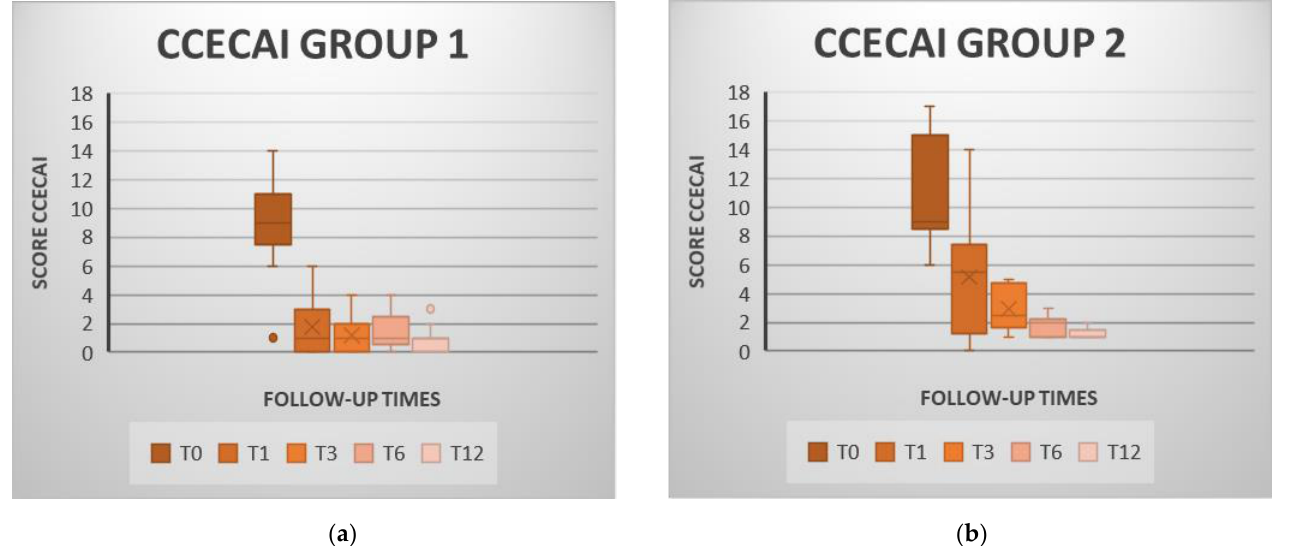
Figure 3. Values of the Canine Chronic Enteropathy Clinical Activity Index (CCECAI) for the cell therapy group (MSC group; figure ( a )) and for the combined prednisone and stem cells group (P-MSC group; figure ( b )) at each review. In both groups, it is observed how the CCECAI decreases gradually over the time, highlighting the decrease between T0 and T1. Box and Whisker Plot: The graphs show the median (line inside the box), 25th and 75th percentiles (box) and minimum and maximum values (whiskers).